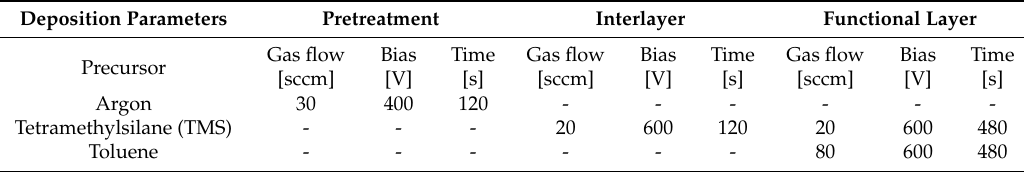
Table 2. Deposition parameters at 4 × 10 − 3 mbar basic pressure; 1 sccm = 1.667 × 10 − 9 m 3 /